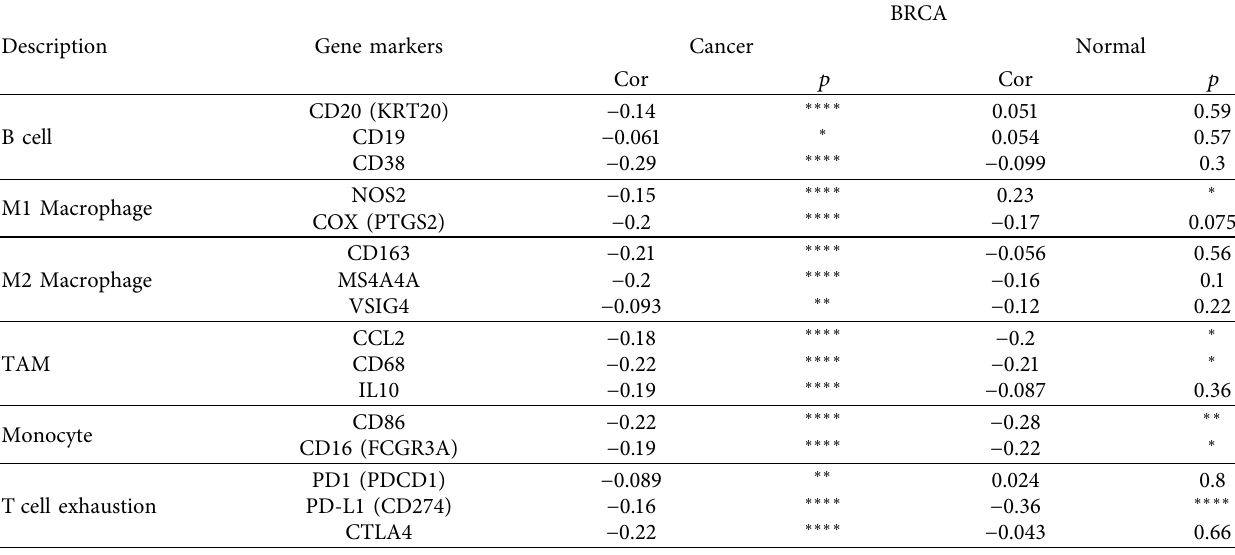
Table 3: Correlation analysis between MYL5 and relate genes and markers of B cell, macrophages, TAM, monocyte, and Tcell exhaustion in GEPIA2. Description Gene markers